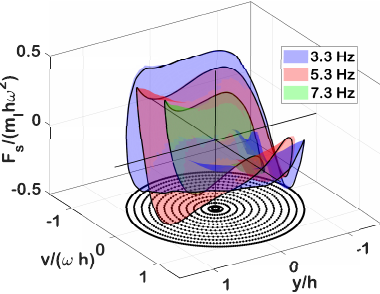
Figure 7. Interpolated experimental response surfaces. Circular traces shown in the horizontal plane corresponding to the 3.3 Hz response